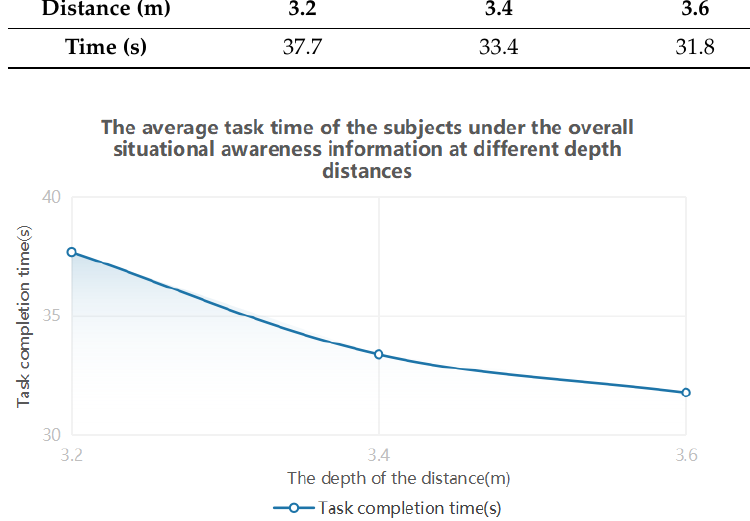
Table 8. Time data after division of the overall situational awareness information depths and dis- tance ranges. Figure 12. Time variation trend of the overall situational awareness information to complete tasks at different depths and distances.